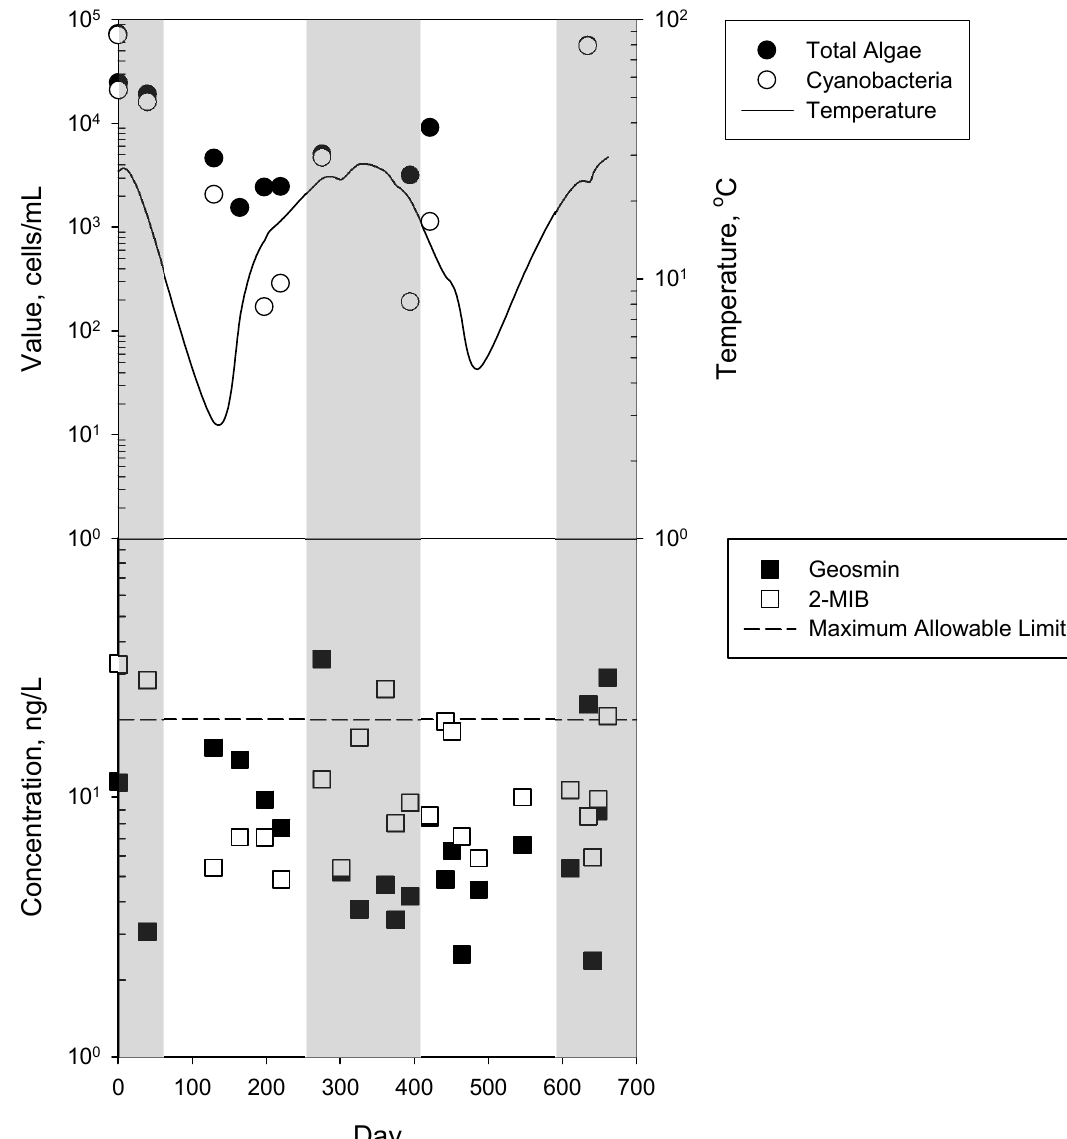
Figure 2. Temporal correlation patterns of geosmin and 2-methylisoborneol (2-MIB) with total algae and cyanobacteria in intake water (the gray period is from May to October).